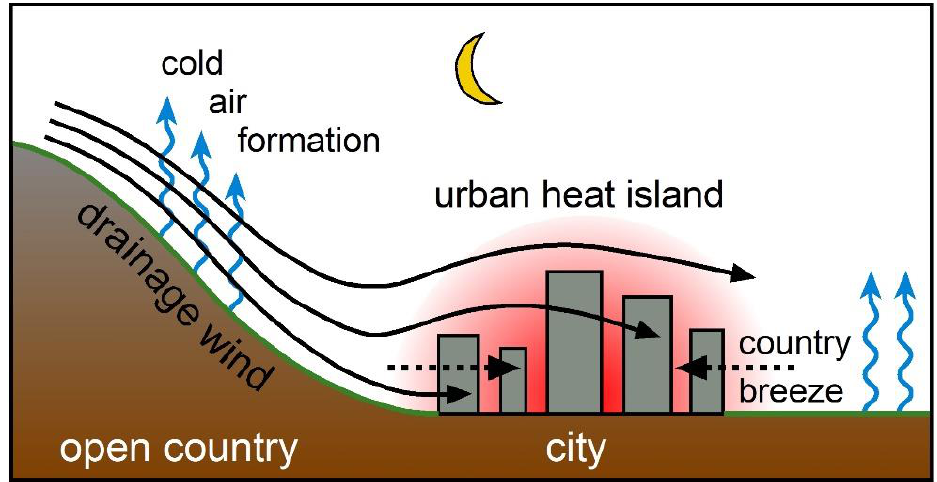
Figure 1. Schematic figure of a city located on a valley floor with illustrations of the urban heat island (red color shading), rural cold air formation (blue wavy arrows) and cold air flows by drainage winds (solid black arrows) and country breezes (dashed black arrows) during night time.